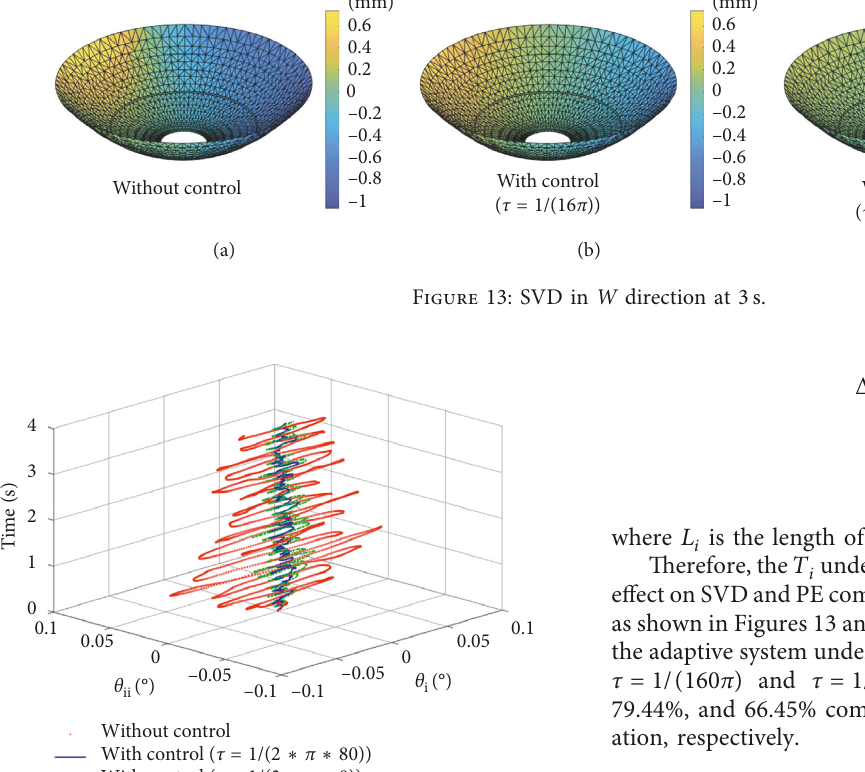
Figure 14: PEs without control and with